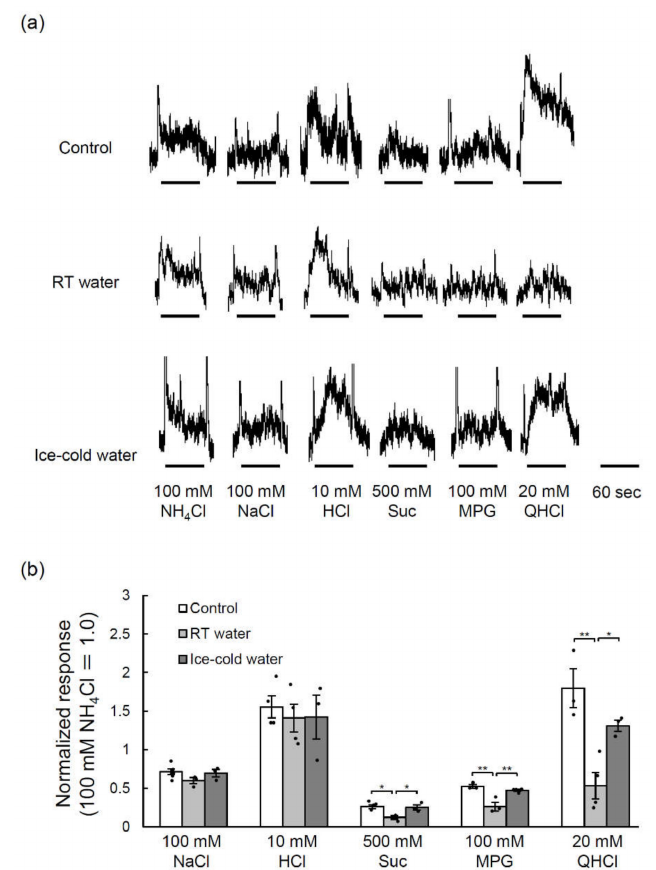
Figure 5. Glossopharyngeal nerve responses to various taste stimuli before and 10 days